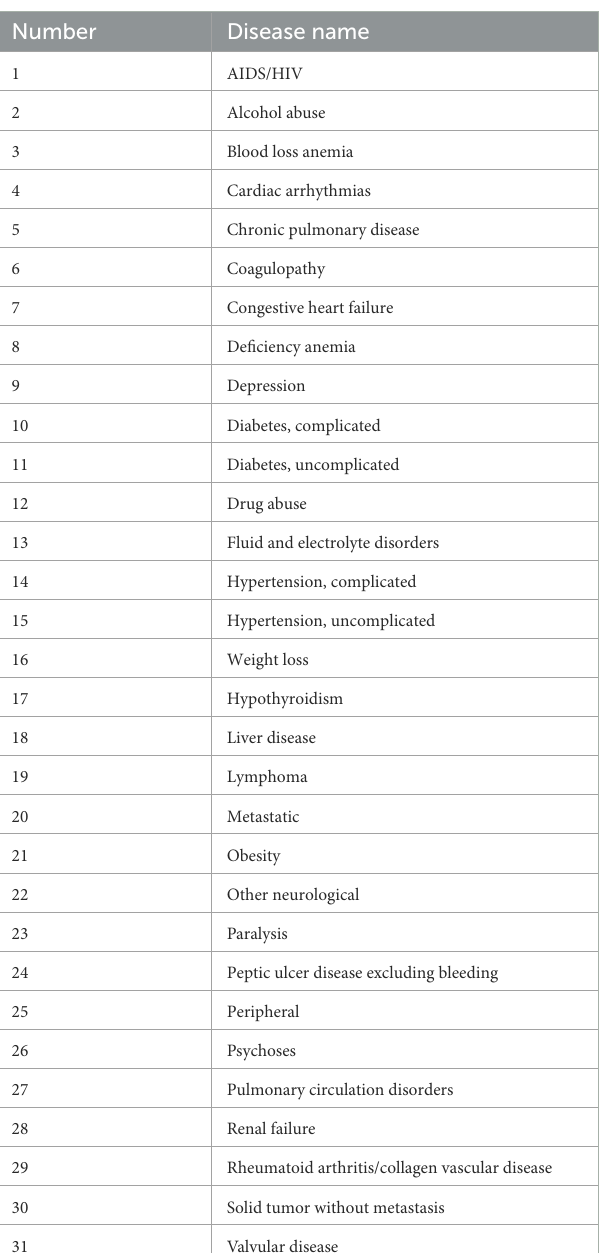
TABLE 3 Elixhauser disease